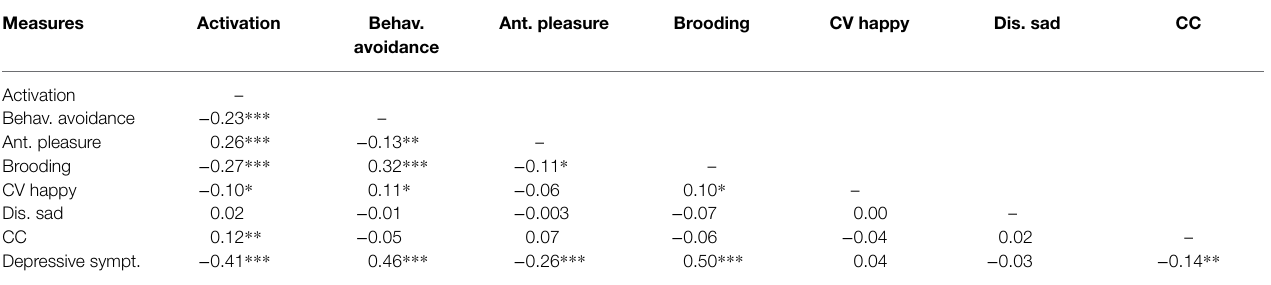
TABLE 3 | Spearman’s correlations between all variables.